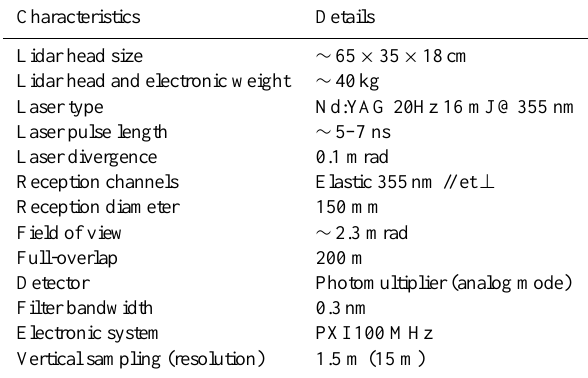
Table 1. Main characteristic of the airborne lidar